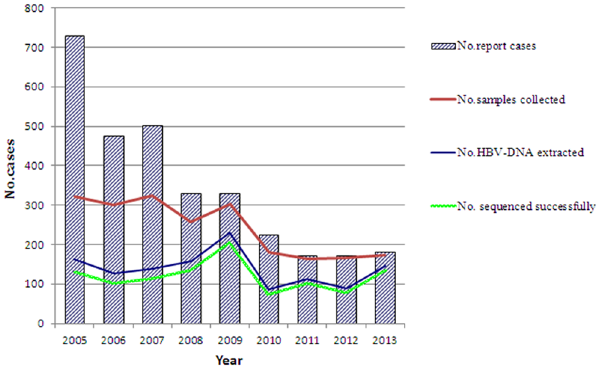
Figure 1. Annual numbers of HBV cases aged 0–14 years reported through NNDRS, with samples collected, HBV-DNA extracted and successfully sequenced in Shandong Province, China,